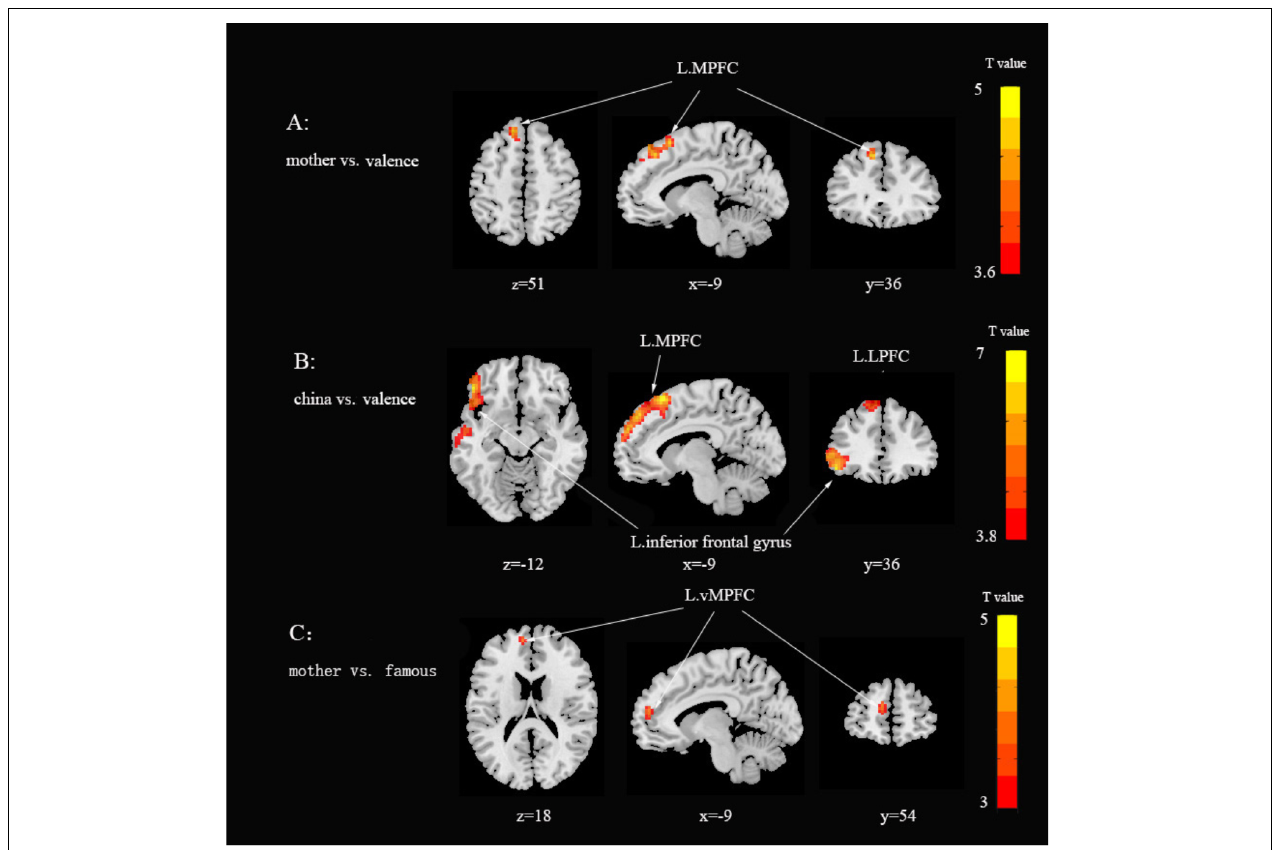
FIGURE 4 | Brain activations reveals in different contrast, p < 0.05, corrected by Alphasim, a combined threshold of p < 0.001, and a minimum cluster size of 54 voxels. (A) mother vs. valence; (B) china vs. valence; (C) mother vs. famous.